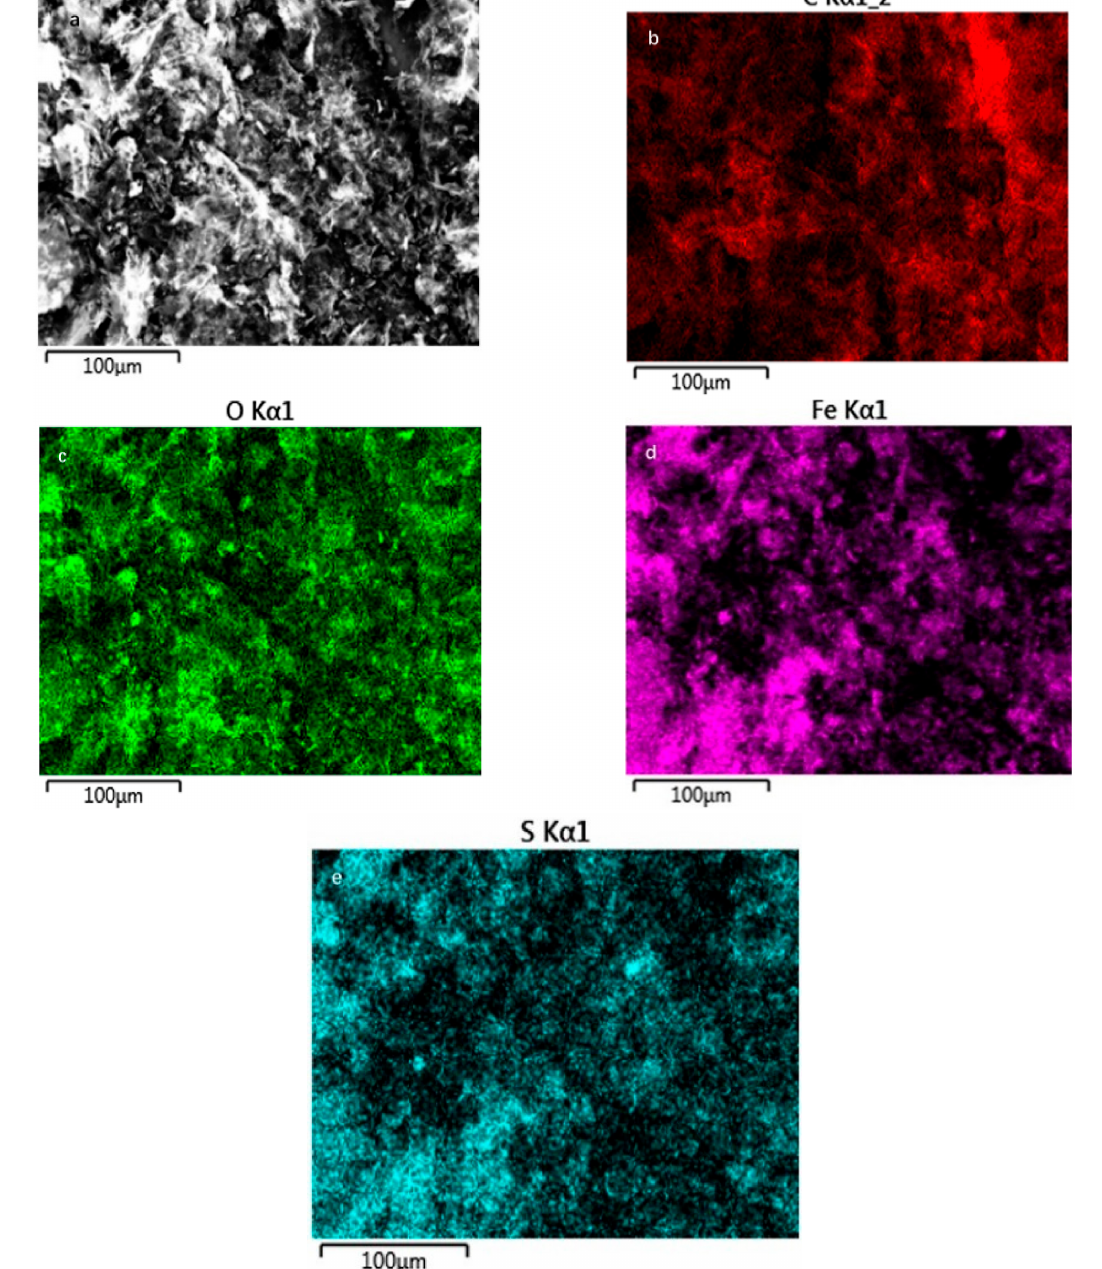
Figure 4. The FESEM image of FeOOH-GA 0.25 ( a ) and corresponding element mapping images of C ( b ), O ( c ), Fe ( d ) and S ( e